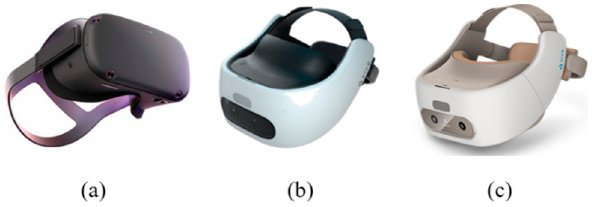
Figure 1. The VR HMDs for the experiment. ( a ) Oculus Quest; ( b ) Vive Focus Plus; ( c ) Vive Focus. Three independent variables containing stimuli were investigated in the research to better know how they affect the threshold of stray light perceived by the observer: visual field, grayscale, and the VR HMD device. The stimulus of the visual field was the radius of the light source displayed on the image. The size of the stimulus was defined by adding the inside and outside diameter pixels and dividing by 4. For example, the circle image number of the largest visual field stimulus was 750 ((1550 pixels of outside diameter + 1450 pixels of inside diameter)/4), as shown in Figure 2. Sixteen ring patterns, with sizes varying from 0 to 750, were acquired, and the difference between the inside and the outside diameter was 50 pixels. Figure 2 illustrates the images with different visual field stimuli. For grayscale stimuli, all the color depths of the VR HMDs were 8-bit RGB values, and, thus, 20 grayscales, ranging from 10 to 200, with ten intervals were designed and are shown in Figure 3. The test image background was set as 0 to exclude the stray light from the device itself. Both visual field and grayscale stimuli were controlled by the images presented on the VR HMD. In addition, the dependent variable was the threshold of the stray light perceived by the human eye. According to the observer’s subjective evaluation, the visible stray light’s grayscale value was recorded for each stimulus with different independent variables. Figure 2. Different stimuli visual fields. Figure 3. Different stimuli grayscale. In total 960 images (16 stimuli visual field × 20 stimuli grayscale × 3 VR HMD devices) with a resolution of 1600 × 1600 pixels were tested in the experiment. The information on the parameters is listed in Table 1. The image VR content from three devices was identical and established by Oculus and Vive Wave software development kit (SDK) with Unity 3D engine. Before starting the experiment, the observers were invited to a completely dark room and adapted to the environment for 10 min. After the adaptation, an experimental